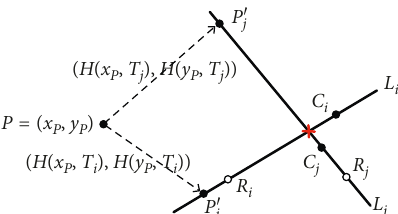
Figure 4: Diagrammatical representation of password point, shifted password points, and challenge and response points for different timestamps in the P-GMGP